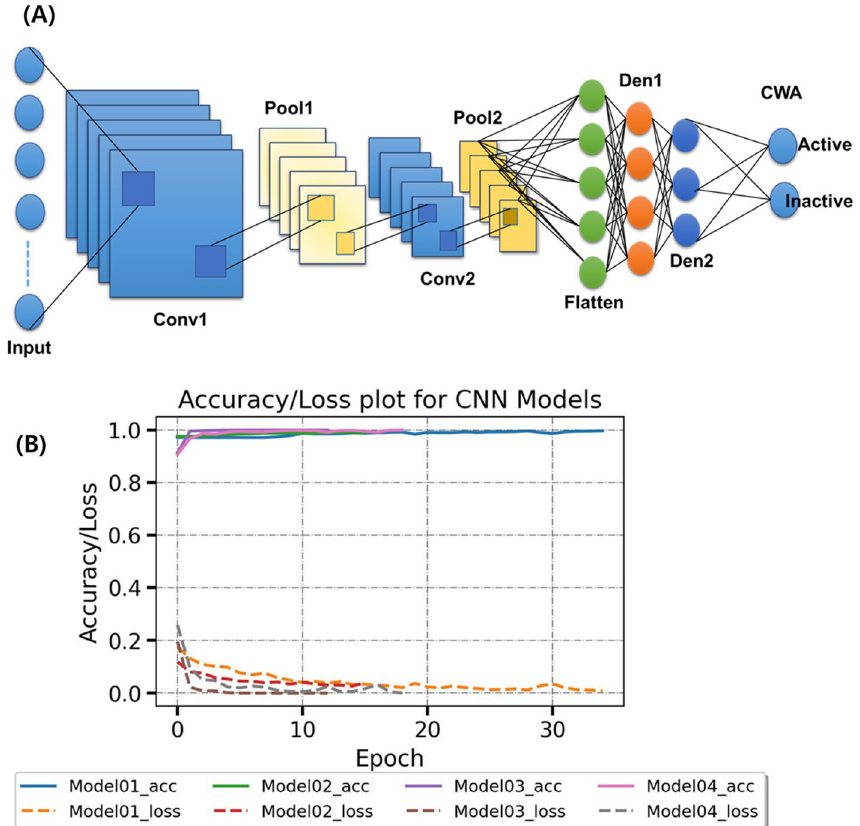
Figure 6. Training of the three different shaped array classifiers (2D, 3D, and reshaped 3D). ( A ) CNN architecture in this study. ( B ) Robust training of the CNN models with early stopping via callback. X-axis: the number of epochs (training unit), y-axis: accuracy or loss values (the gap between real and prediction), which were calculated by a loss function according to data sampling (Model 01: native, Model 02: removal of duplicated array values from Model 01 data, Model 03: SMOTE oversampling of Model 01 data, Model 04: SMOTE oversampling of Model 02